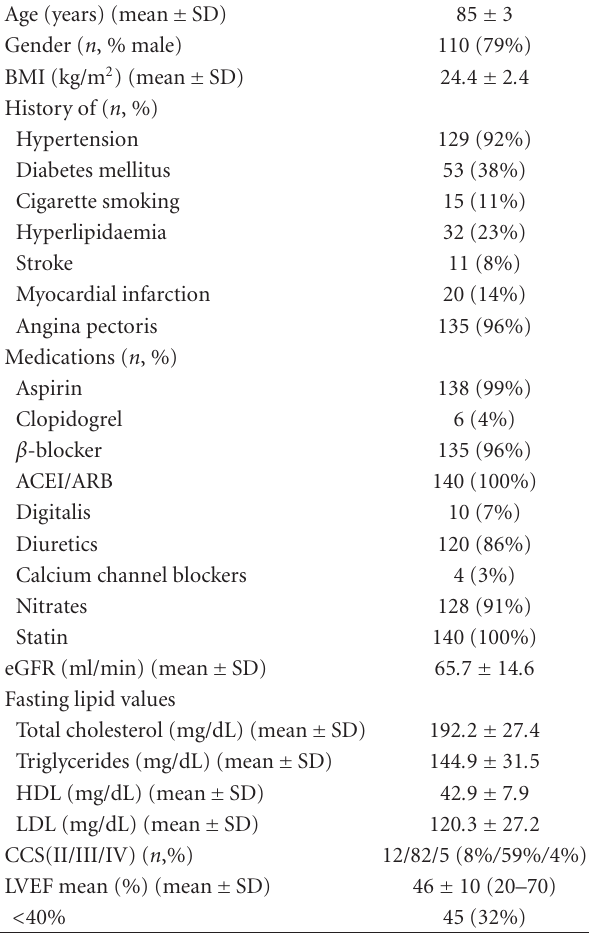
Table 1: Baseline clinical